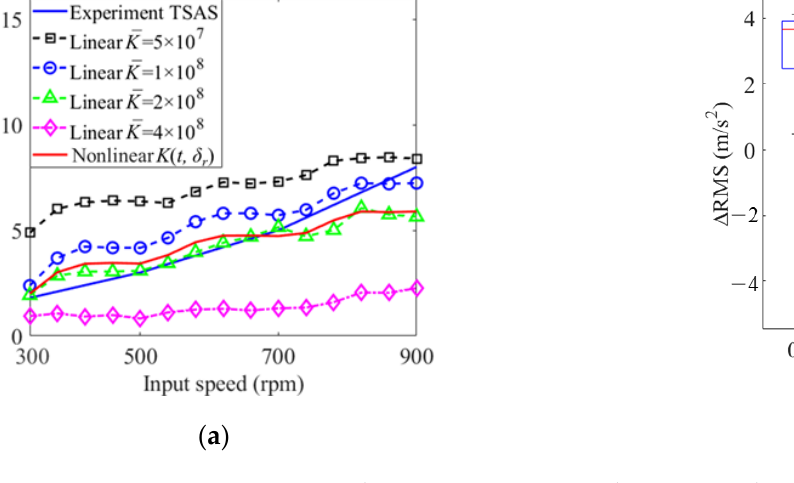
Figure 11. Vibration RMS comparison between simulated results and experimental results: ( a ) time- history vibration response; ( b ) boxplot. Table 2. Support stiffness parameters of the simulation